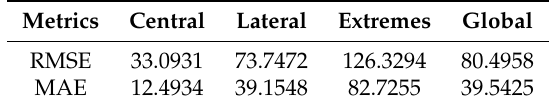
Table 3. Validation of segmentation results using the test